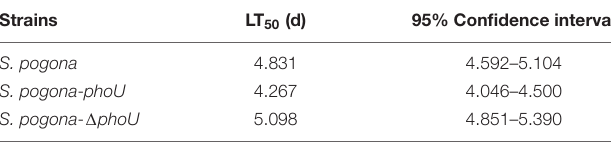
TABLE 1 | Biological insecticidal activity of the wild-type and recombinant